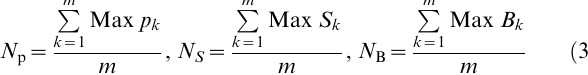
Figure S1 Average of the Largest Clusters (as a function of MEC) of all protein-DNA complexes in the dataset. (P-p graph in